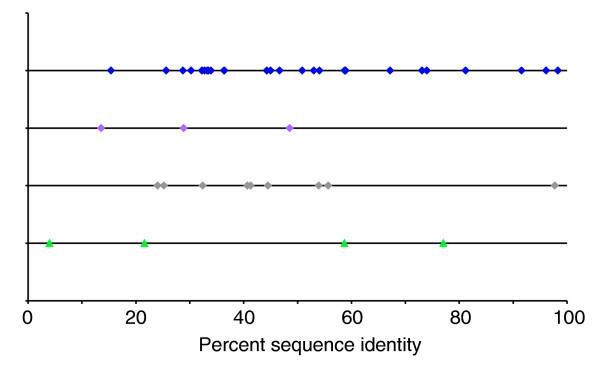
Percent of sequence identity between the 41 duplicated protein pairs. Proteins were classified as belonging to the same class (blue diamonds), different classes with the same function (pink diamonds), different classes with different functions (gray diamonds), or not classified (green triangles).